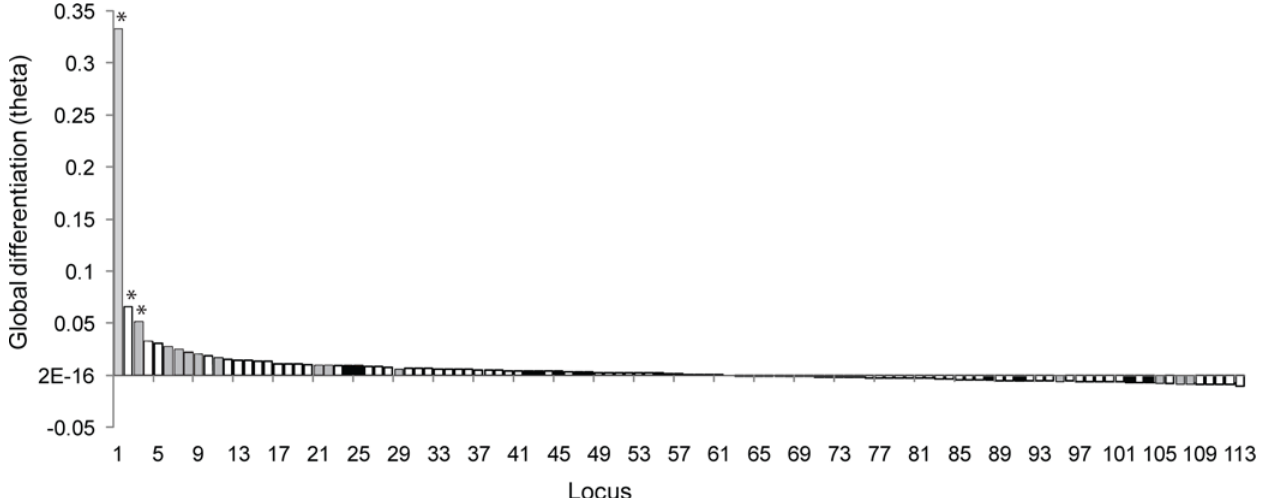
Fig 2. Locus specific differentiation across six GoR samples. Global differentiation (Weir-Cockerham ’ s θ ) for 18 microsatellite (dark grey bars) and 95 SNP (open bars) loci ranked by θ . Hatched bars indicate SNP loci identified as selected outliers in [14] and asterisks above bars indicate three loci identified as outliers in this study. See S1 Table for locus ID. Global θ across loci and samples was